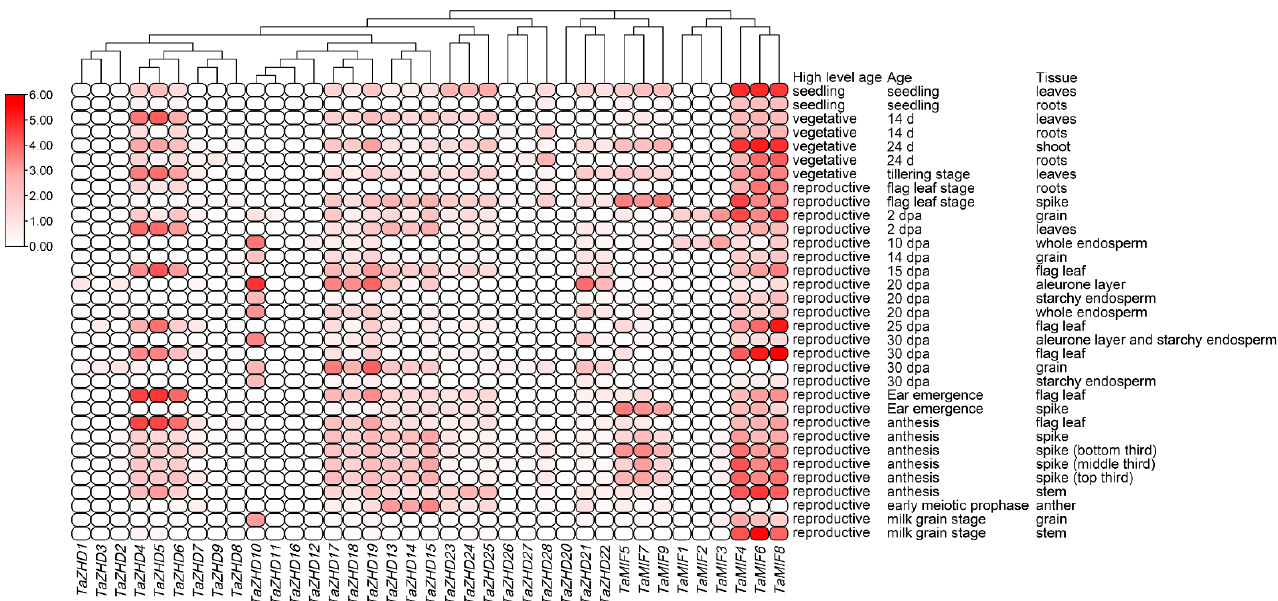
Figure 6. Tissue-specific expression patterns of the TaZF-HD genes in various wheat tissues. The log 2 of TPM (transcripts per million) values were calculated by RNA-seq data to show the expression levels of the TaZF-HD genes in wheat.